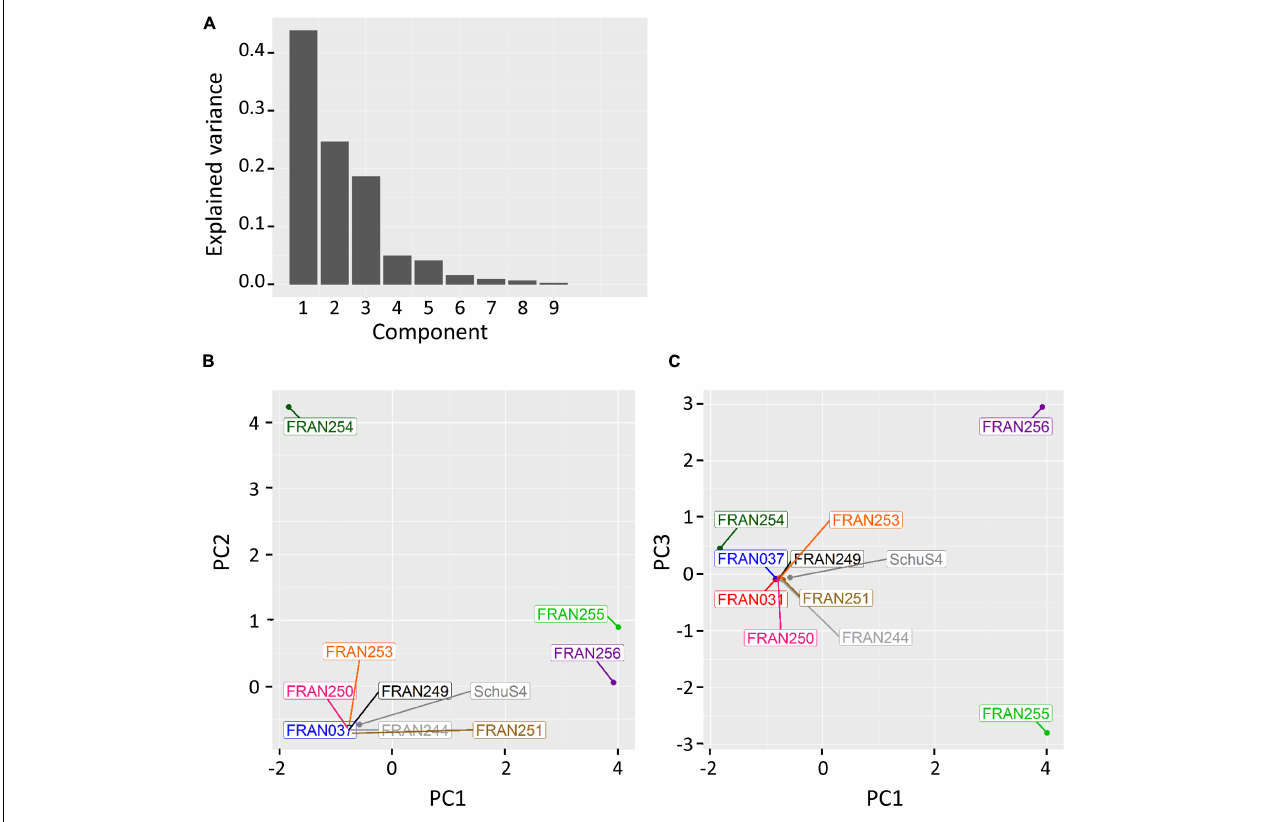
FIGURE 2 | Principal component analysis of whole genome data. Prokka-annotated genomes were analyzed with Roary to identify orthologous sequences. Principal component analysis was then performed on the cloud genes using the presence/absence tables generated from the Roary analysis. (A) Explained variance for each principle component. PCA plots were generated for PC2 vs. PC1 (B) and PC3 vs. PC1 (C) .